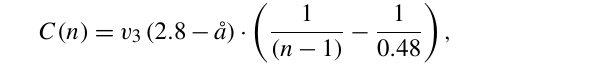
micron distributions. C(n) is equal to 0 for å ≥ 2 . 8 and